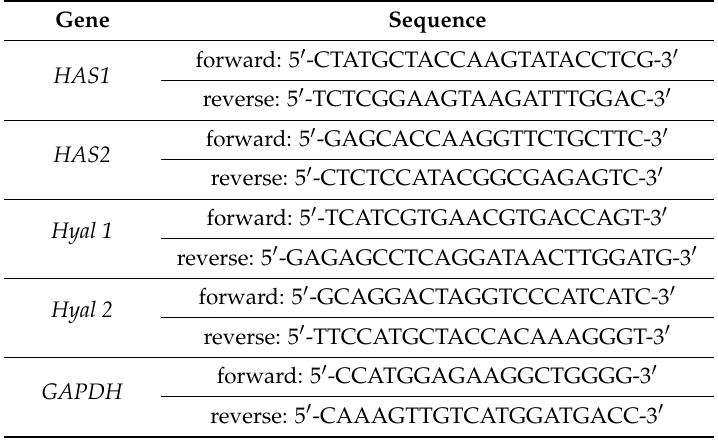
Table 2. Primer sequences used for quantification of gene